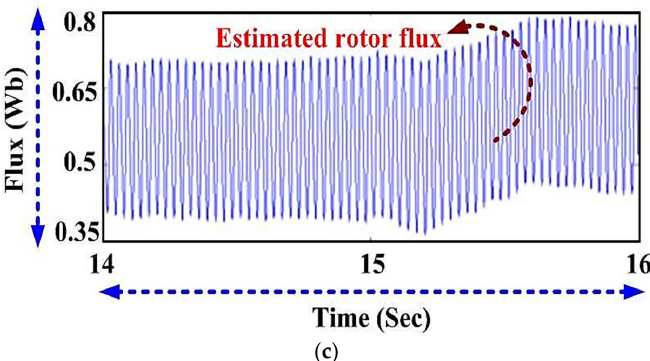
Figure 7. SMLO1: ( a ) estimated speed; ( b ) estimated torque and ( c ) estimated rotor flux.